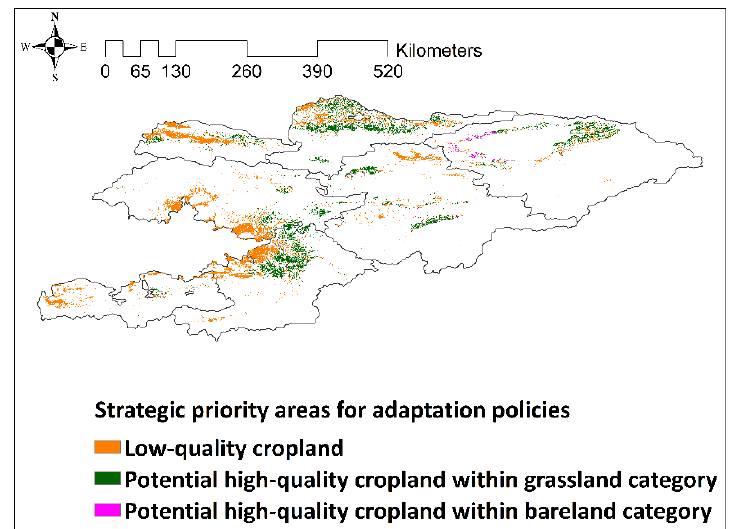
Figure 6. Strategic priority regions for agricultural adaptation policies.